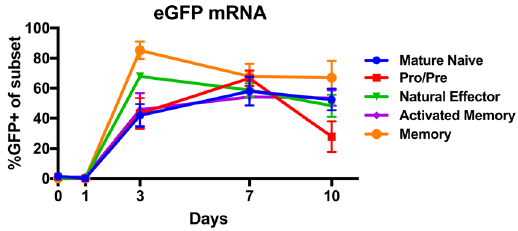
Figure 3. B cells become permissive to electroporation in culture. Frequency of EGFP + cells 2 days after electroporation with mRNA encoding EGFP ( left panel ) at the indicated time points (n = 6).